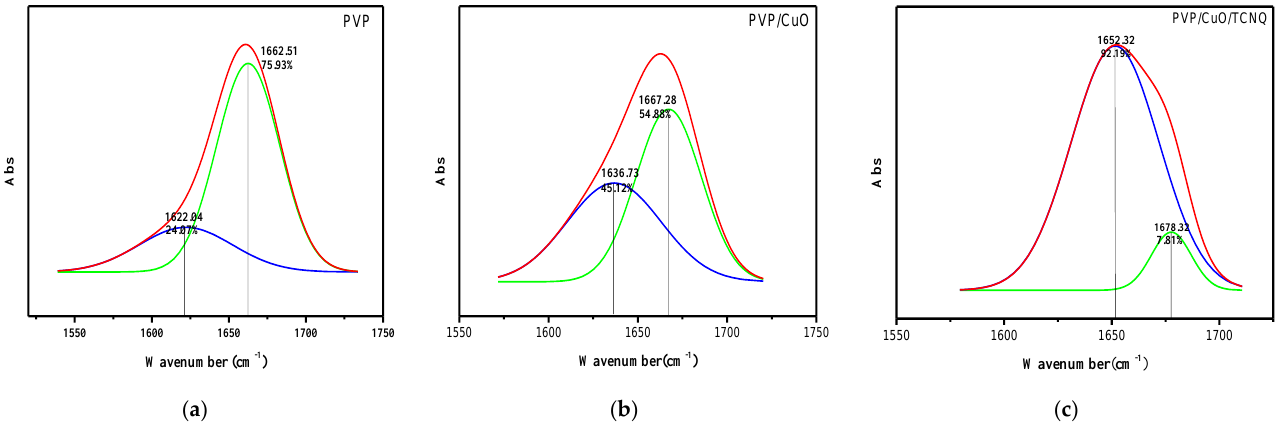
Figure 3. Deconvoluted IR spectra of ( a ) PVP, ( b ) PVP/CuO composite, and ( c ) PVP/CuO/TCNQ composite .